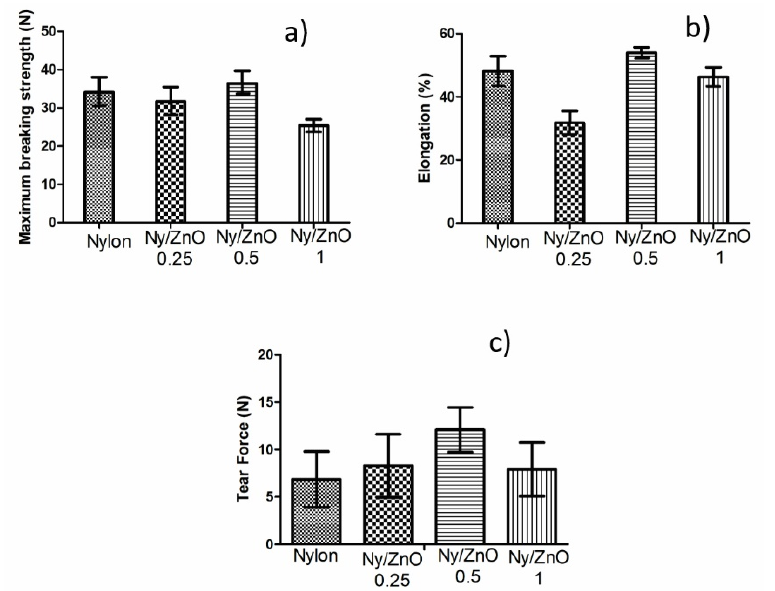
Figure 3. Mechanical properties of non-woven fabrics: ( a ) maximum breaking strength; ( b ) elongation %; and ( c ) tear force.